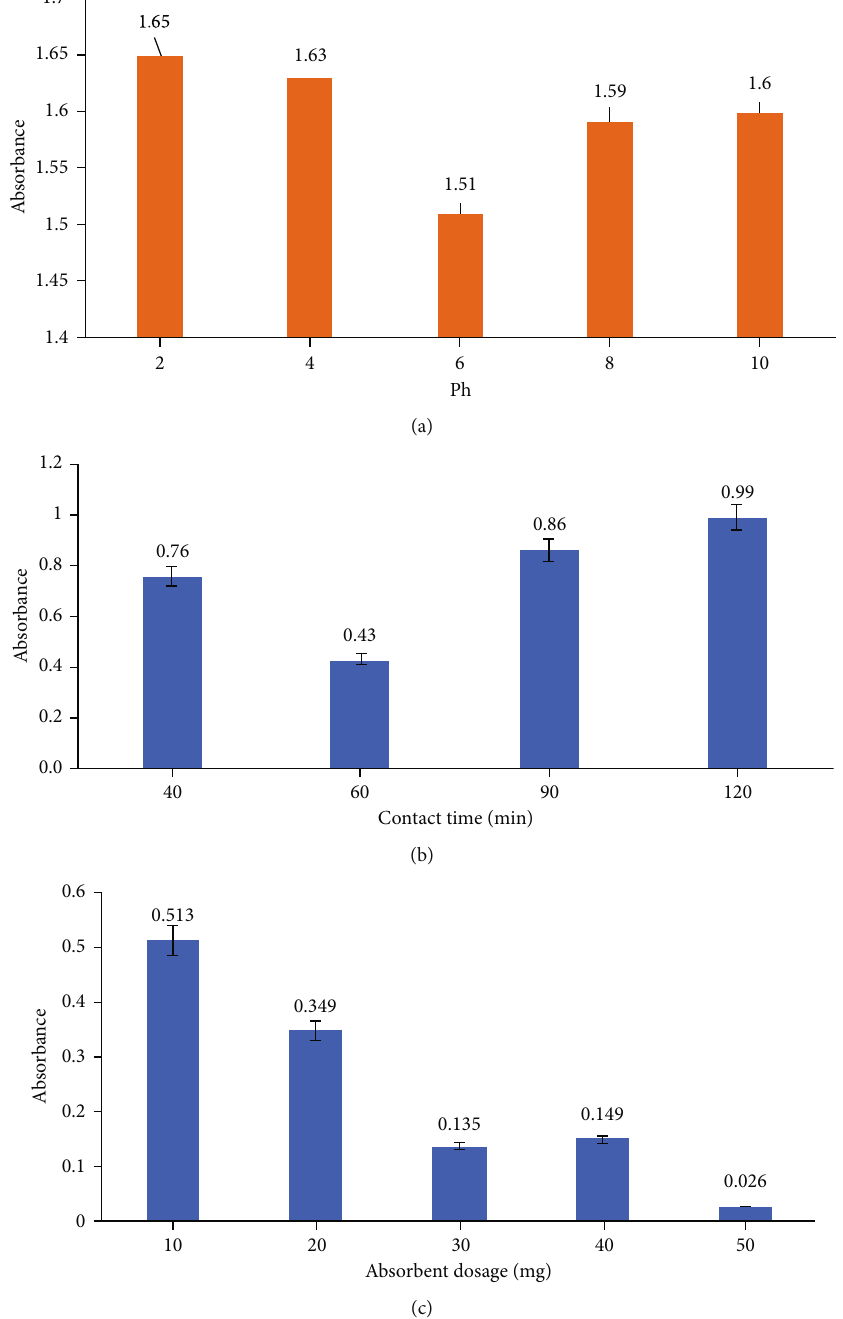
Figure 5: Optimization parameters for the removal of Cr from aqueous solution on the basis of (a) e ff ect of pH, (b) e ff ect of contact time, and (c) e ff ect of adsorbent